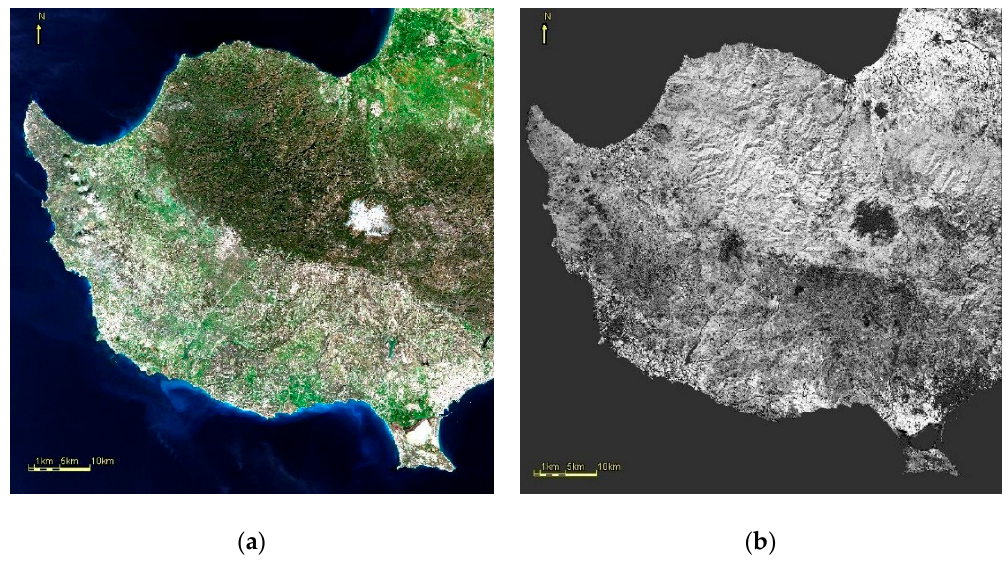
Figure 18. ( a ) RGB of Sentinel-2 image and ( b ) NDVI mask developed in SNAP